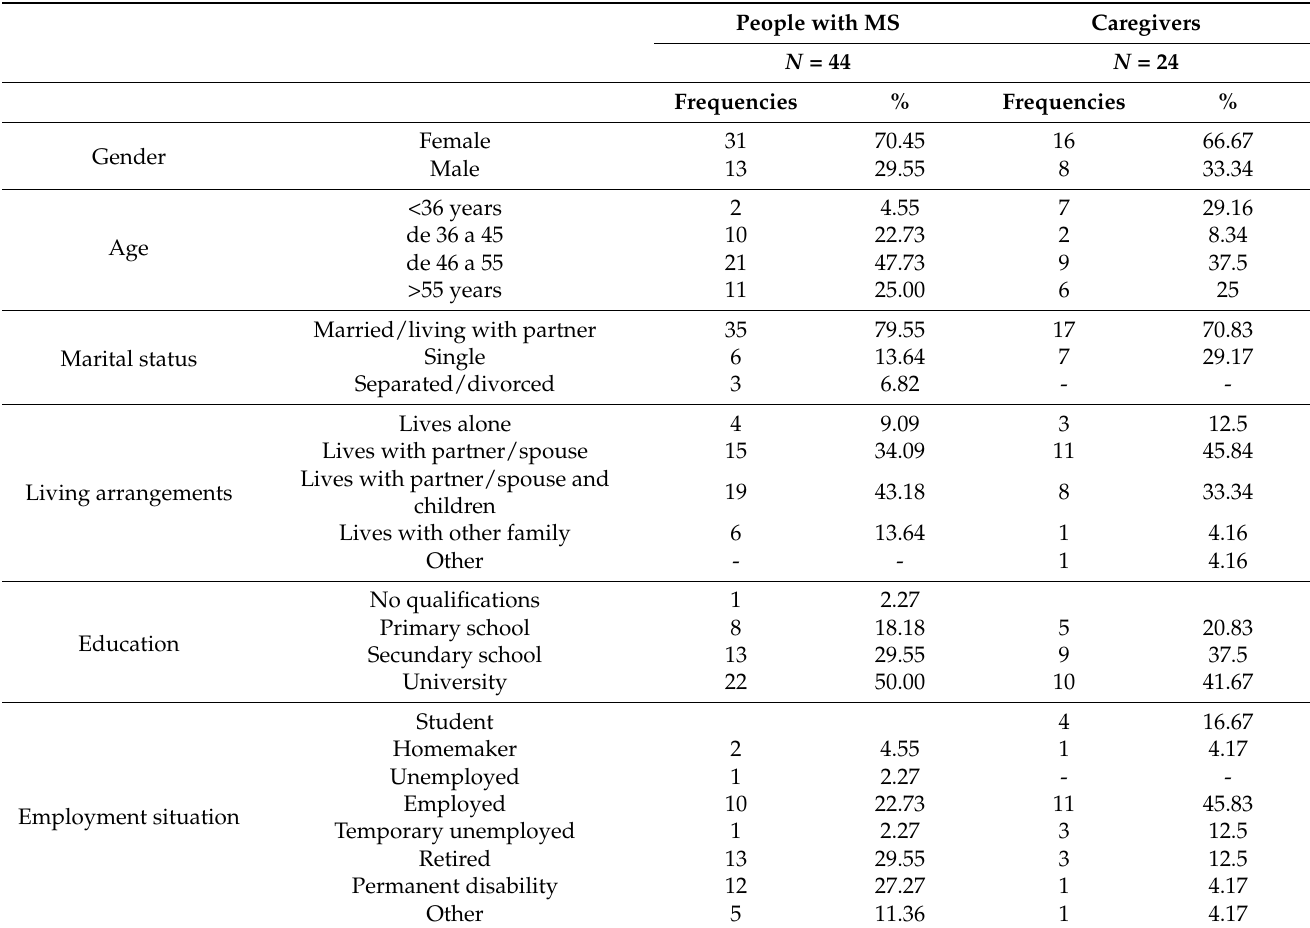
Table 1. Distribution of the samples of people with MS and their caregivers according to sociodemographic